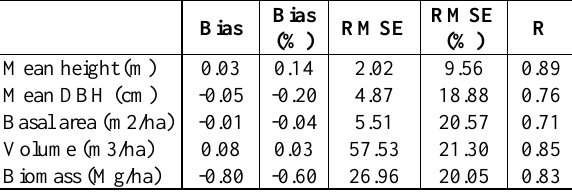
Table 5. Summary of results using TDX InSAR 3D metrics.